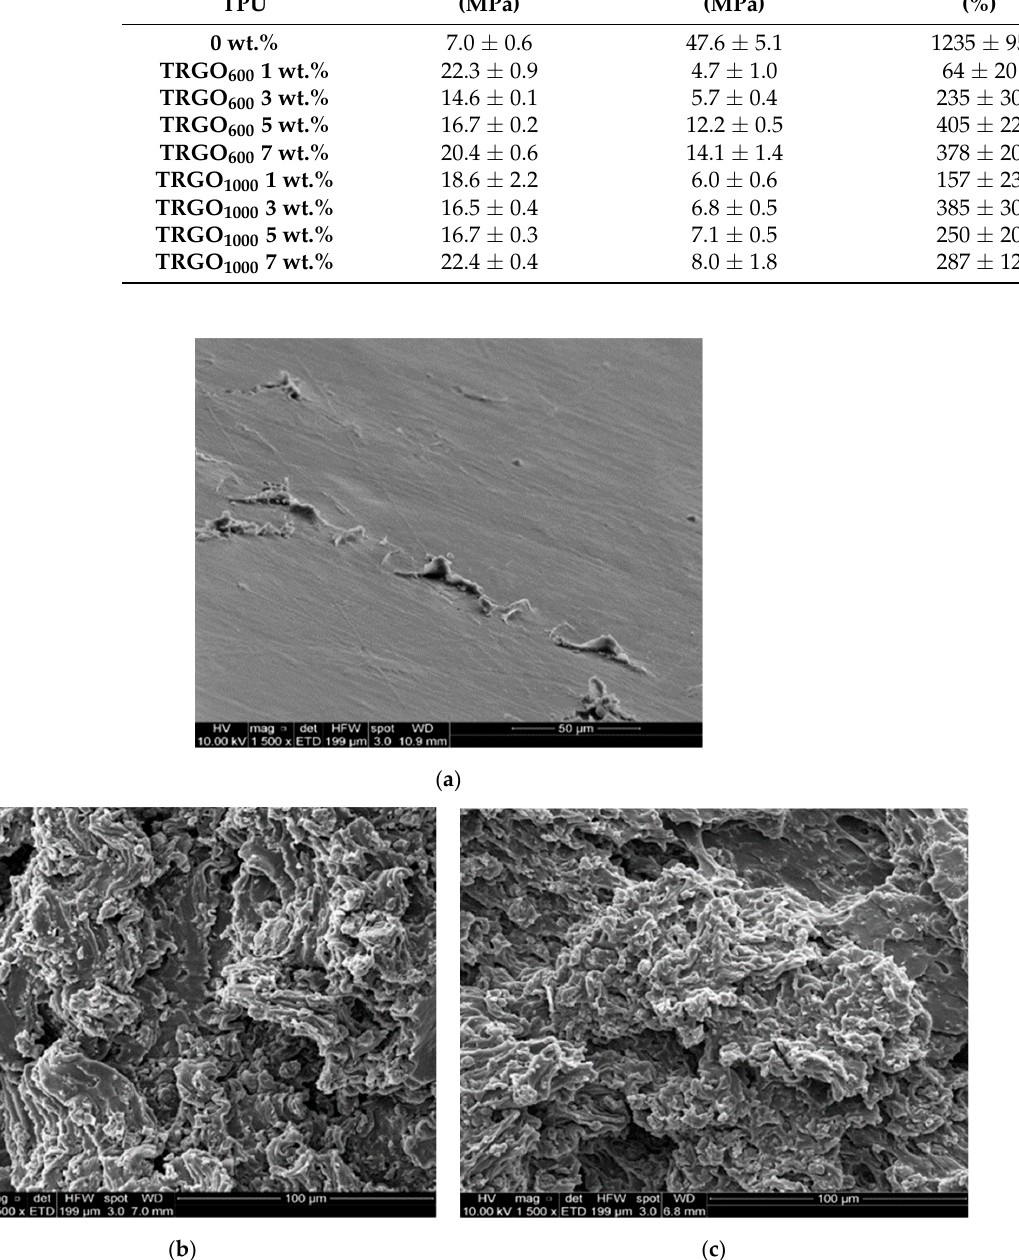
Figure 5. SEM images of TPU ( a ) and TPU-based nanocomposites containing 5 wt.% of TRGO 600 ( b ) and 5 wt.% of TRGO 1000 ( c ).